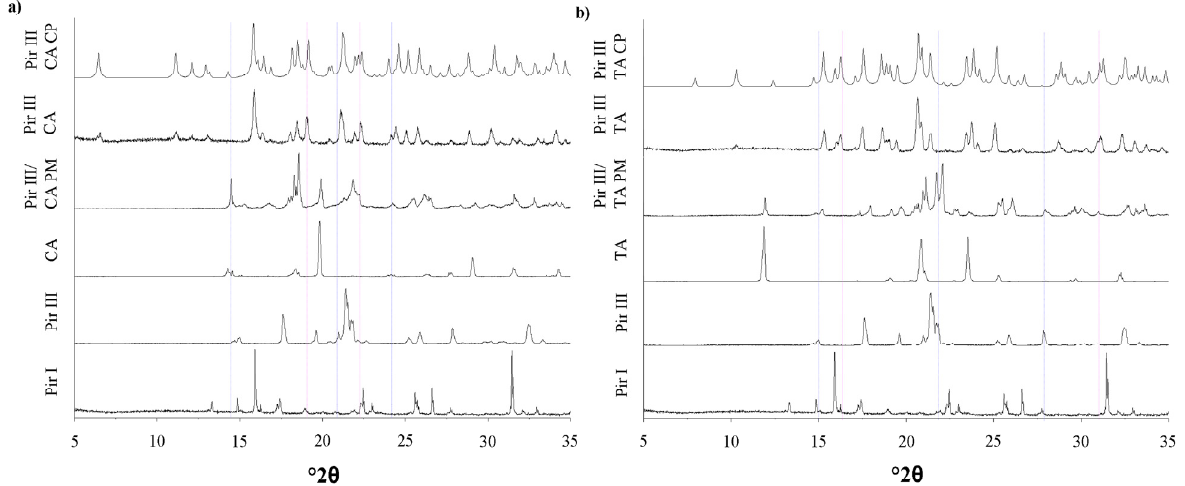
Figure 3. ( a ) XRPD patterns of piracetam form I (Pir I) and form III (Pir III), citric acid (CA), physical mixture of piracetam form III and citric acid (Pir III/CA PM), piracetam-citric acid cocrystal (Pir III CA), and calculated piracetam-citric acid cocrystal pattern (Pir III CA CP). ( b ) XRPD patterns of piracetam form I (Pir I) and form III (Pir III), tartaric acid (TA), physical mixture of piracetam form III and tartaric acid (Pir III/TA PM), piracetam-tartaric acid cocrystal (Pir III TA), and calculated piracetam-tartaric acid cocrystal pattern (Pir III TA CP).